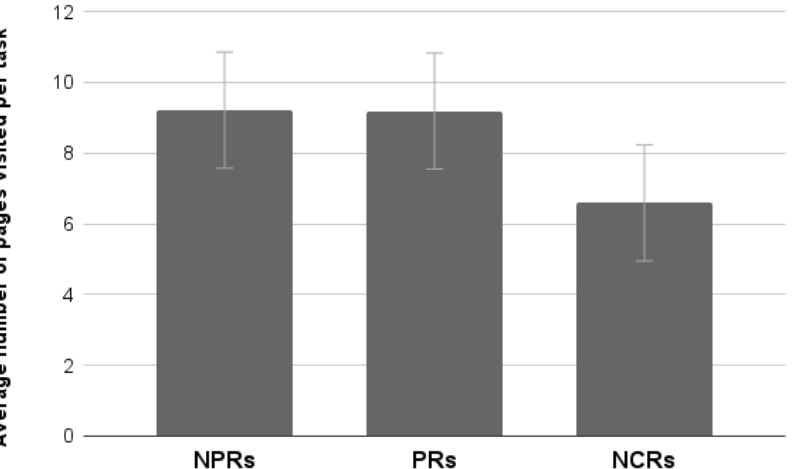
Figure 21. Average number of pages visited per task by Group (NPRs vs. PRs vs. NCRs). Error bars denote 0.95 confidence intervals.